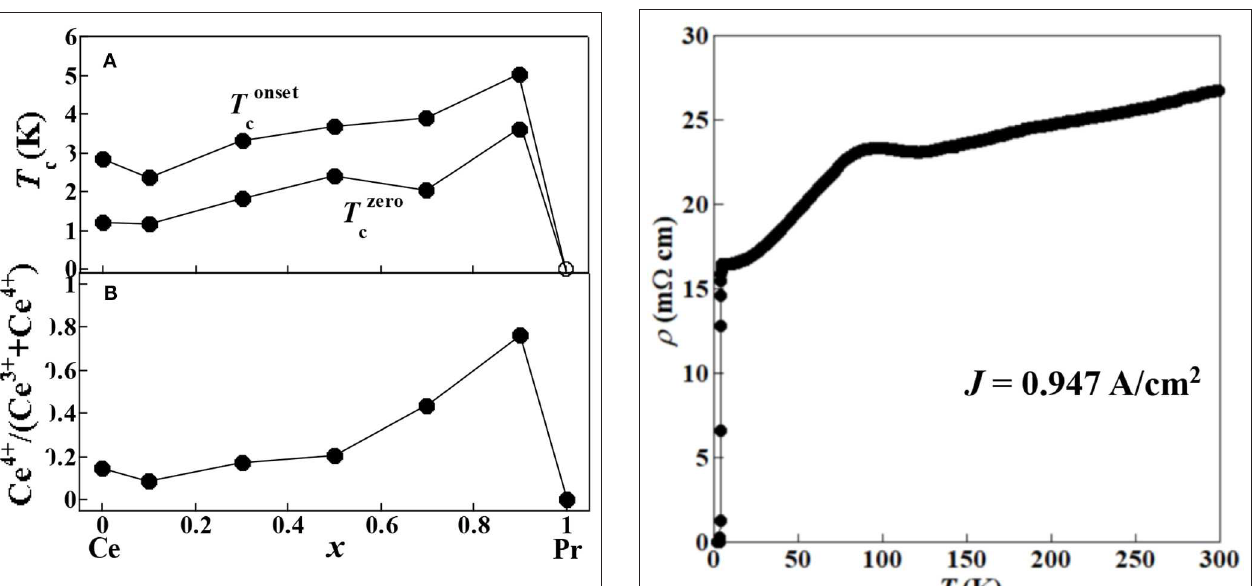
FIGURE 7 | (A) The Pr contents ( x ) dependence of T onset c and T zero c for (Ce,Pr)OBiS 2 with 0 ≤ x ≤ 0.9 and PrOBiS 2 ( x = 1) (Nagao et al., 2019) single crystals. (B) The Pr contents ( x ) dependence of Ce 4 + ratio [Ce 4 + /(Ce 3 + + Ce 4 + )] in (Ce,Pr)OBiS 2 with 0 ≤ x ≤ 1.0 single crystals.